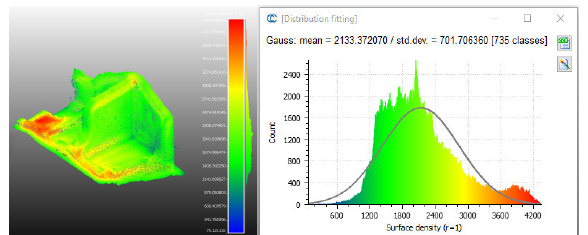
Figure 10b. Density analysis of the project 7 (all the five acquisitions) – Sample B